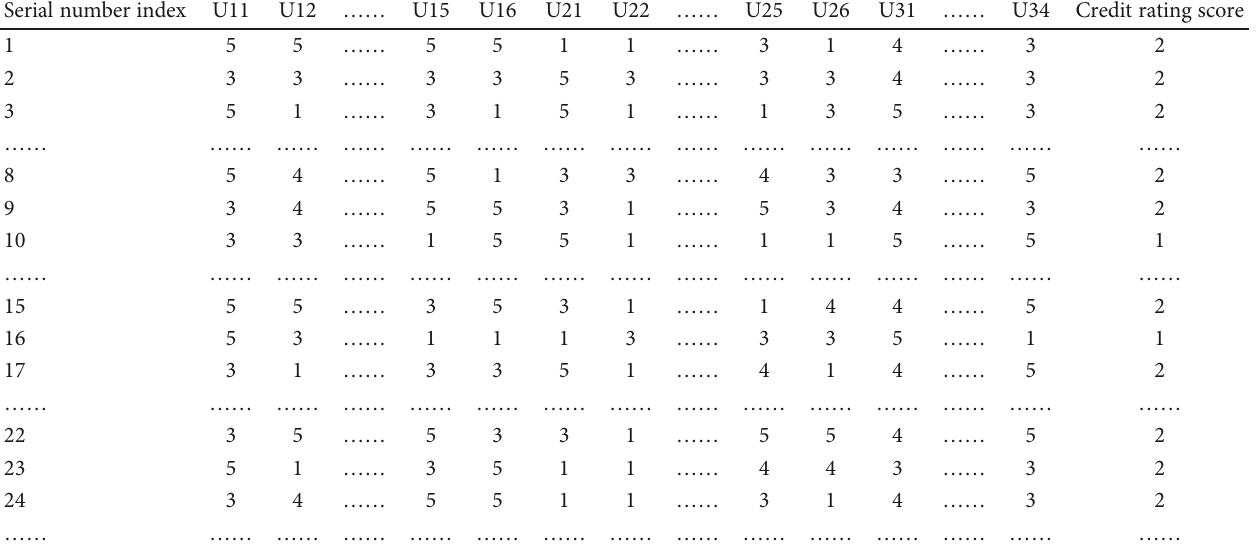
Figure 4: Big data processing fl ow. Table 2: